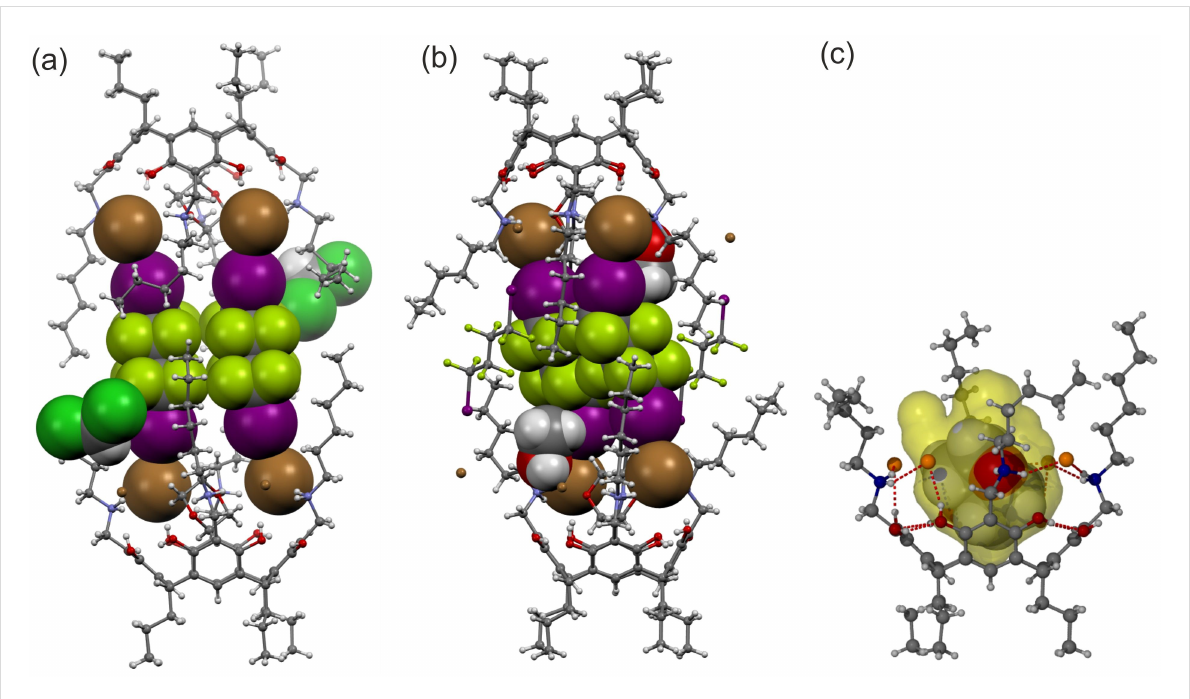
Figure 2: The previously reported halogen-bonded complexes CHCl 3 @ 1 &DIOFB (a), and MeOH@ 1 &DIOFB (b). (c)The fit of 1,4-dioxane within the cavity of 1 [32].